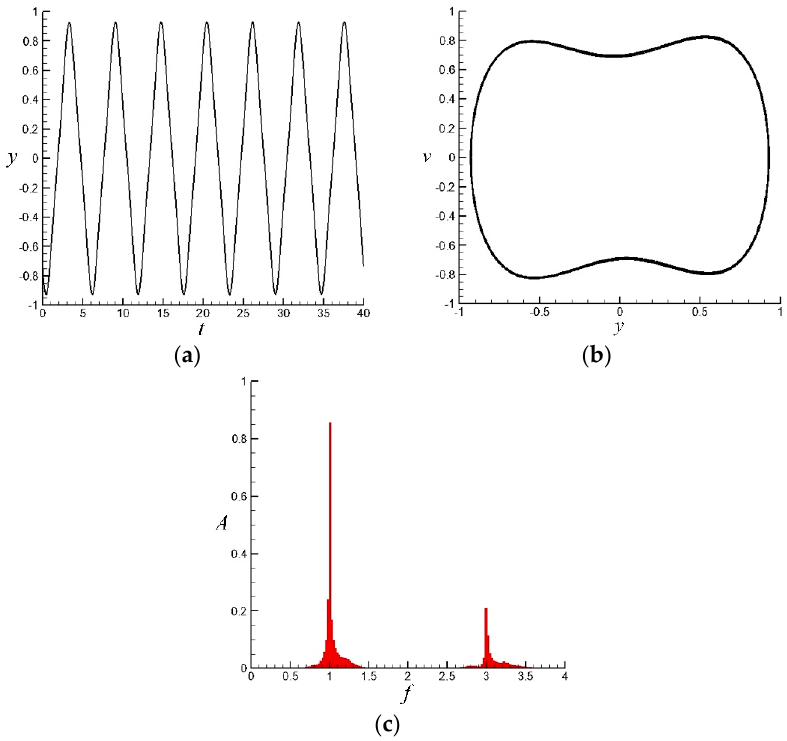
Figure 6. Response of the model with effective control ( 1 f = ): ( a ) Time–displacement ( y t − ) diagram; ( b ) Velocity–displacement phase ( v y − ) diagram; ( c ) FFT of displacement ( A f − ).